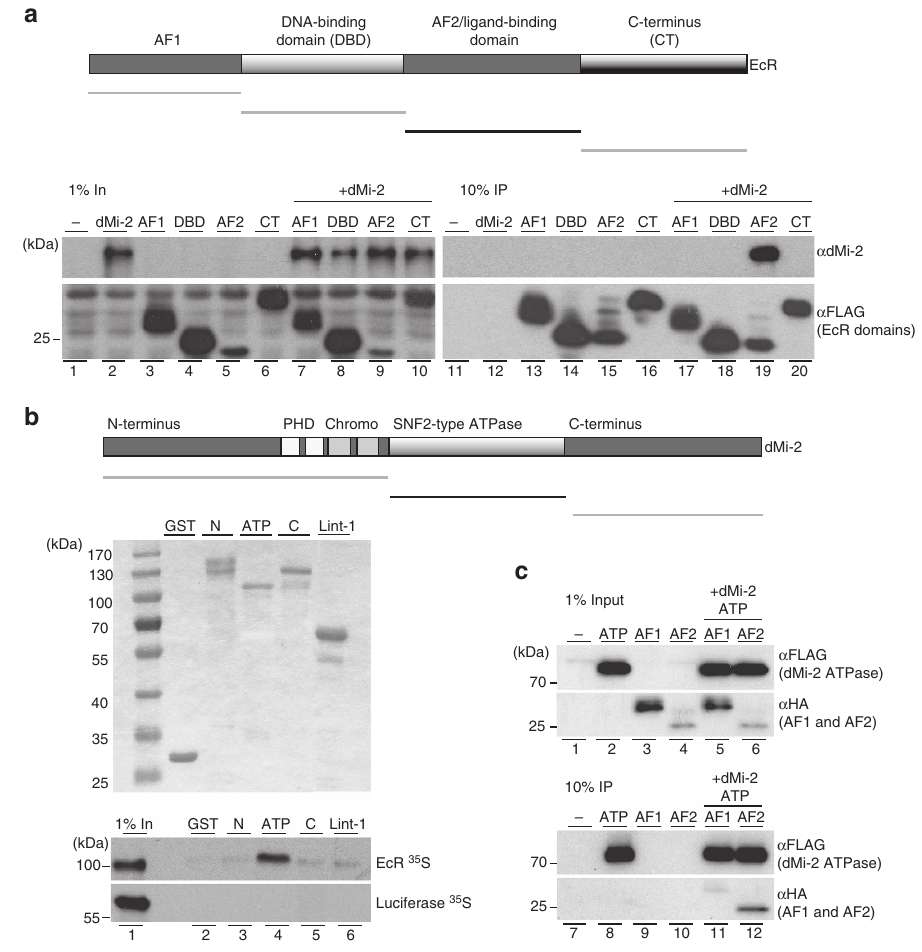
Figure 5 | EcR LBD/AF2 domain and dMi-2 ATPase domain interact. ( a ) Top: Schematic representation of EcR domain structure and deletion constructs used for interaction assay. Bottom: Sf9 cells were infected with baculoviruses expressing dMi-2 and FLAG-tagged EcR domains as indicated on top. Cell extracts were analysed by western blot for the expression of recombinant proteins (left panel, 1% input). Extracts were immunoprecipitated with FLAG antibody and immunoprecipitates were analysed by western blot (right panel, 10% IP). Antibodies used are indicated on the right, molecular masses are shown on the left. ( b ) Top: Schematic representation of dMi-2 domain structure and deletion constructs used for interaction assay. Middle panel: Coommassie-stained SDS–PAGE gel of GST constructs used. Bottom panel: Autoradiography of SDS–PAGE gel showing 35 S-EcR (top half) and 35 S-Luciferase (bottom half) bound to GST constructs. Lane 1: 1% input. Molecular masses are indicated on the left. ( c ) Sf9 cells were infected with baculoviruses expressing the FLAG-tagged ATPase domain of dMi-2, the HA-tagged AF1 domain of EcR or the HA-tagged LBD/AF2 domain of EcR as indicated on top. Cell extracts were analysed by western blot for expression of recombinant proteins (top panel, 1% input). Extracts were immunoprecipitated with FLAG antibody and immunoprecipitates were analysed by western blot (bottom panel, 10% IP). Antibodies used are indicated on the right, molecular masses are shown on the